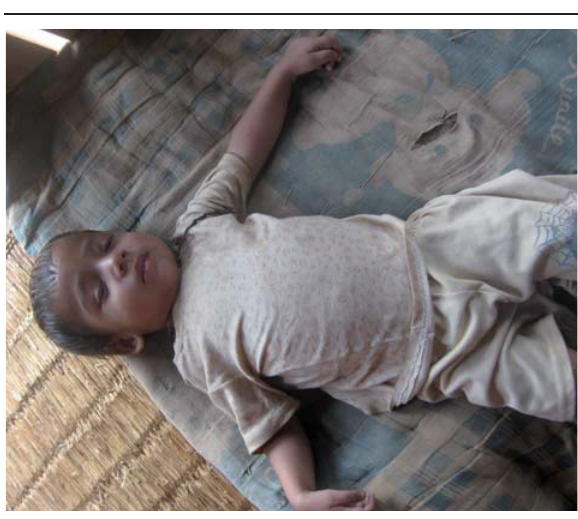
Figure 1.Child with Lysosomal Storage Disease